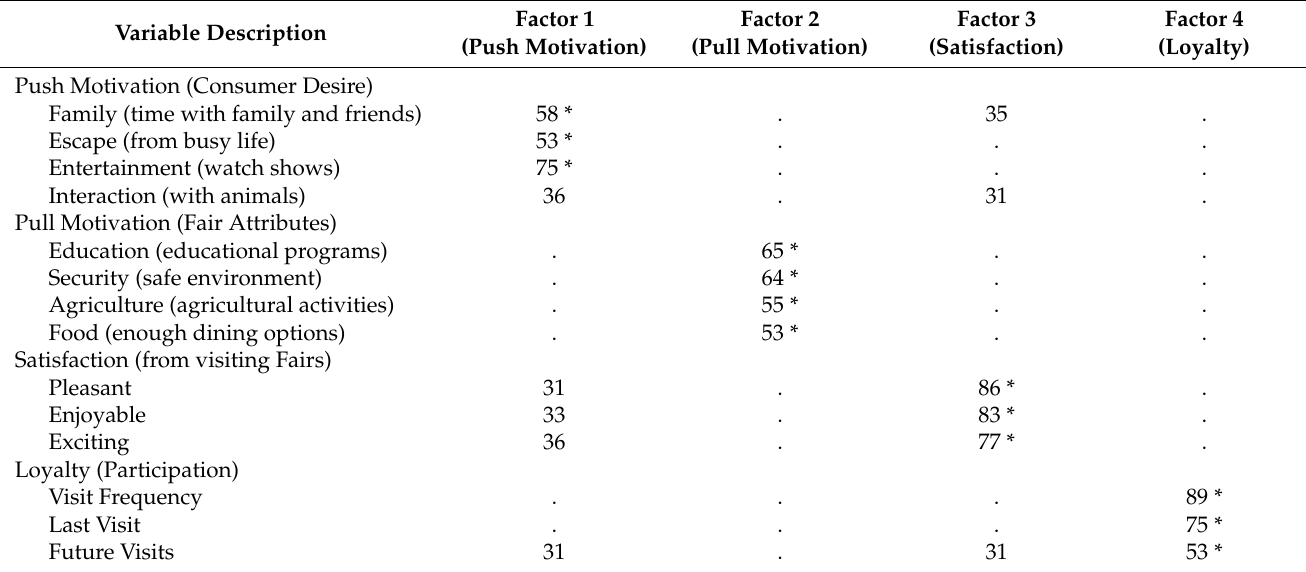
Table 3. Orthogonal transformation